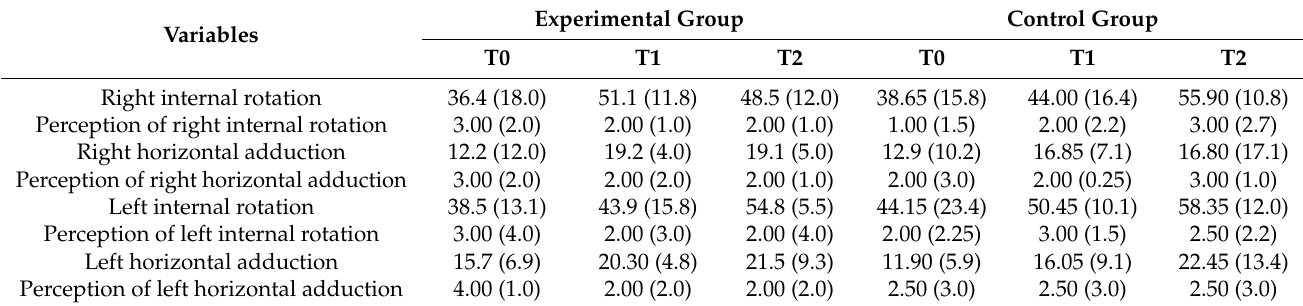
Table 2. Statistical analysis and median (and interquartile range) of the dependent variables of the study at baseline, post-treatment, and follow-up